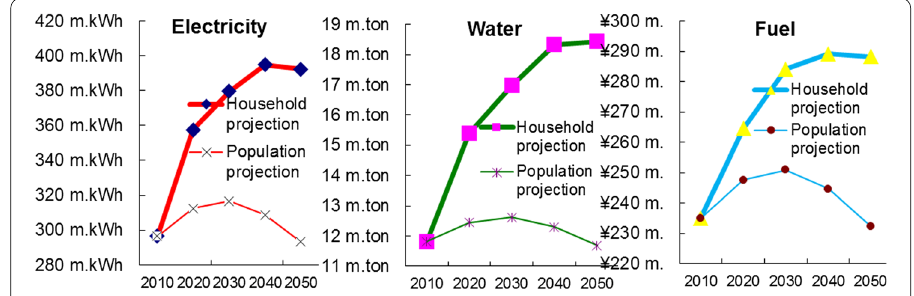
Fig. 1 Comparisons of the residential energy demand forecasting between projections based on household changes and population changes, Hebei province of China, 2010–2050. Notes: (1) “m.” means millions; (2) the unit of electricity is “million kilowatt-hour (m.kWh)”; (3) the unit of water is “million ton” (m.ton); (4) the unit of fuel is “million yuan”, i.e., the total currency costs of different